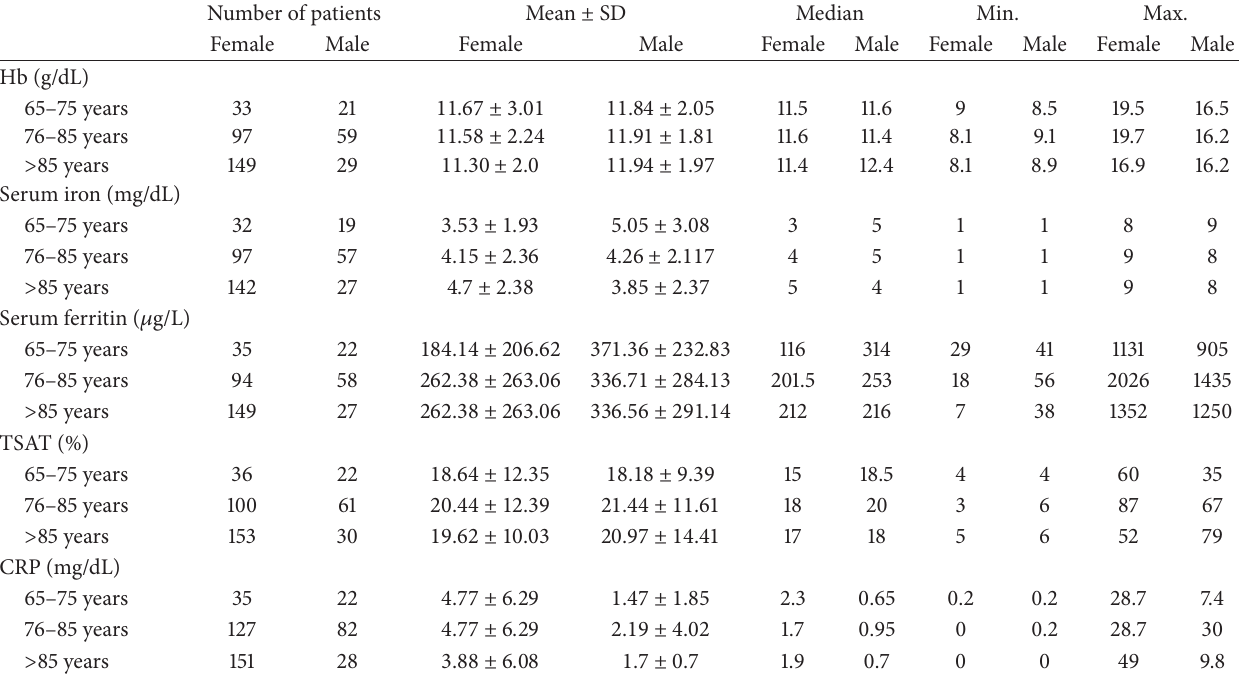
Table 2: Iron parameters in all patients subdivided into age